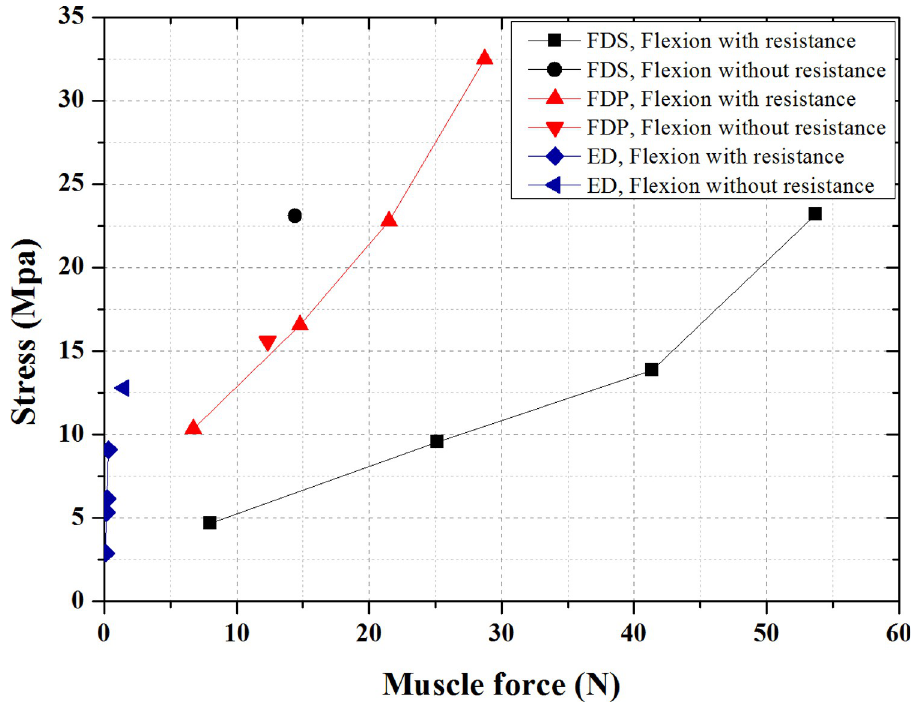
Fig 8. Variation of peak stresses of three muscles with muscle force during flexion movements.